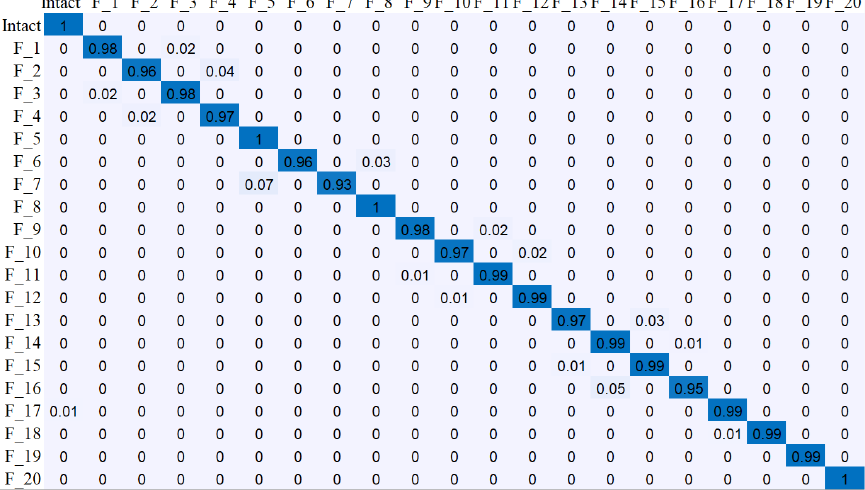
Figure 16. Failure detected location when there are 7 sensors at points 2, 3, 4, 5, 6, 7, and 8 (Accuracy: 98.1%). Table 5. Failure-detection accuracy at different sensor combinations. Table 5. Failure-detection accuracy at di ff erent sensor